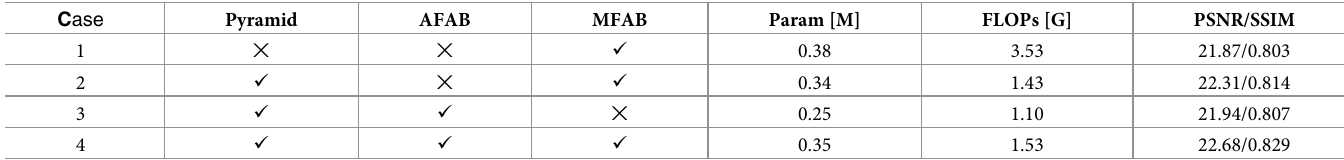
Table 3. Study on EAANet. Pyramid, AFAB and MFAB are pyramid structure, adaptive feature aggregation block and multi-scale feature aggregation block, respectively.